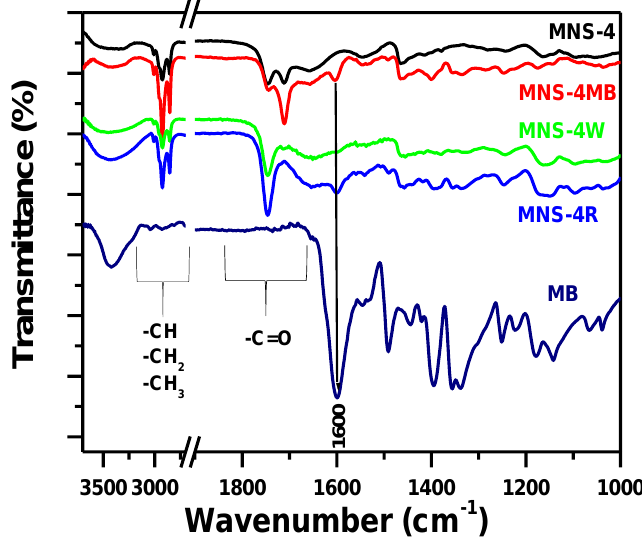
Figure 12. Fourier transform infrared spectroscopy (FTIR) spectra of MNS-4, MNS-4MB, MNS-4W, MNS-4R and MB.